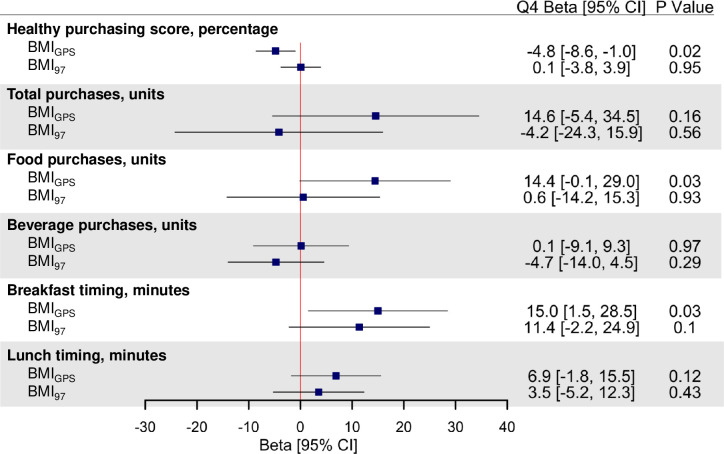
BMI genetic scores associations with quality, quantity, and timing of workplace purchases.Association results are adjusted betas reflecting difference in Healthy Purchasing Score (percentage), items purchased (units over 3-month period), or timing (in minutes) between highest (Q4) and lowest (Q1, reference) quartile of BMI genetic scores adjusted for age, sex, seasonality, and 5 principal components of ancestry. Higher purchasing score = healthier purchases (0%–100%). For interpretation purposes, adjusted betas are from models in which outcomes are untransformed, whereas P values are derived from models in which outcomes are inverse normalized. P values are unadjusted for multiple testing, and false discovery rate–corrected P values (Padj) are presented in S2 Table. BMI, body mass index; CI, confidence interval; GPS, genome-wide polygenic score.